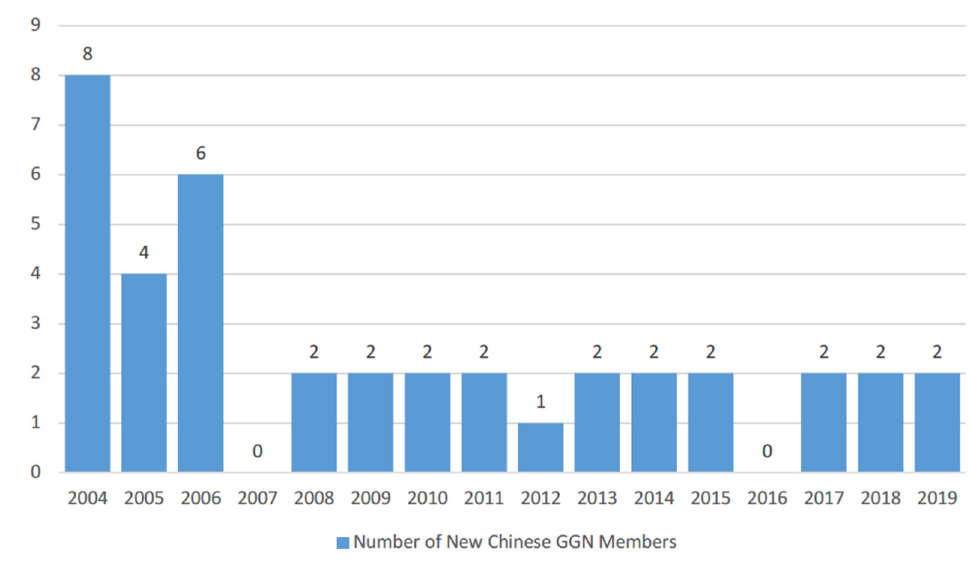
Figure 8. Number of New GGN members from China (2004–2019).